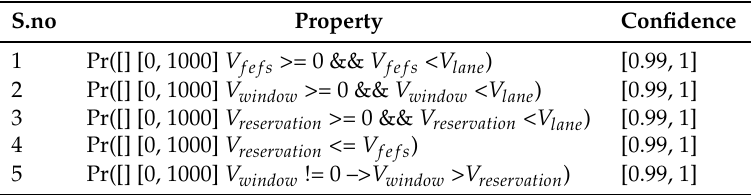
Table 4. Properties checked for invariant satisfiability.